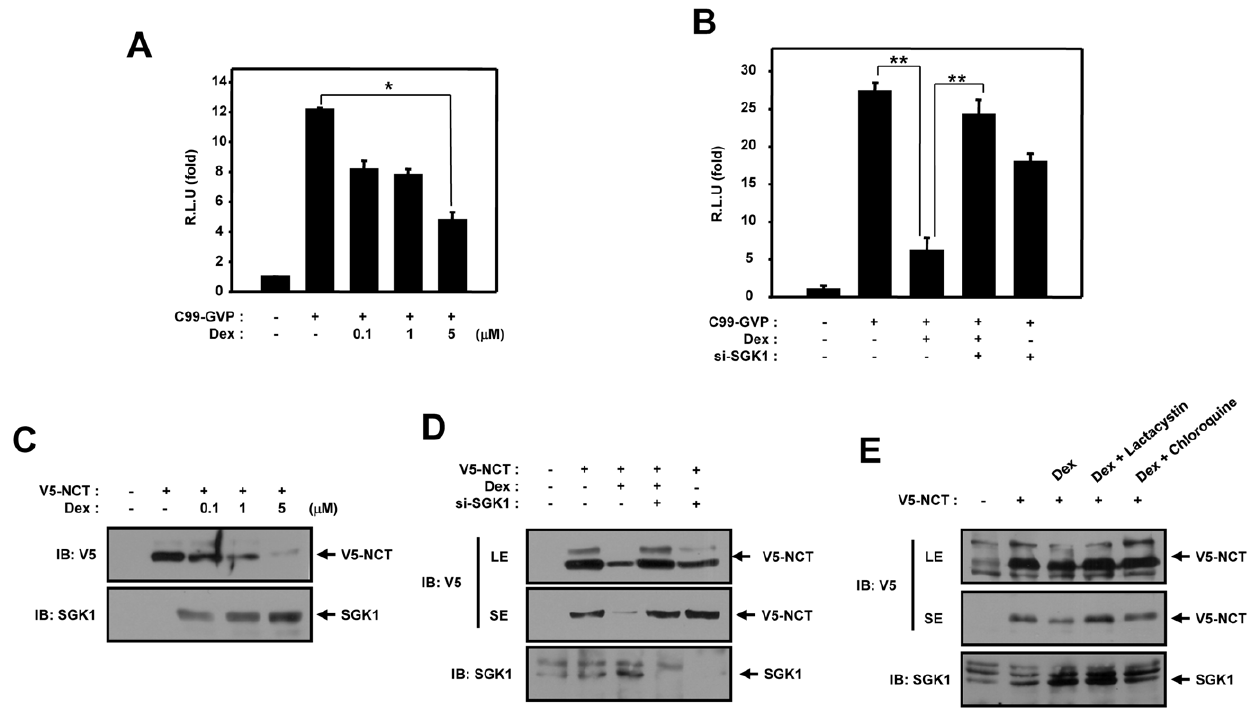
Figure 4. Induced SGK1 by dexamethasone downregulates the NCT protein levels. (A) HEK293 cells were transfected with expression vectors encoding for 200 ng of C99-Gal4/VP16, 100 ng of GAL4-Luc with 100 ng of beta-galactosidase and exposed to 0.1, 1, 5 m M dexamethasone for 24 hours. (B) HEK293 cells were transfected with expression vectors encoding for 200 ng of C99-Gal4/VP16, 100 ng of GAL4-Luc, 100 ng of beta- galactosidase with 400 ng of siSGK1 and exposed to 1 m M dexamethasone for 24 hours. After 48 hours of transfection, the cells were lysed and the luciferase activity was assayed. Data were normalized to beta-galactosidase activity. The results are expressed as the means 6 SEM from three independent experiments. RLU means relative luciferase units. The data were evaluated for significant difference using the Student’s t -test; ANOVA, * P , 0.05, ** P , 0.001. (C) HEK293 cells were transfected for 48 hours with expression vectors encoding for 1 m g of V5-NCT and exposed to 0.1, 1 and 5 m M dexamethasone for 24 hours. (D) HEK293 cells were transfected for 48 hours with expression vectors encoding for 1 m g of V5-NCT and 2 m g of si-SGK1and exposed to 5 m M dexamethasone for 24 hours. The cell lysates were immunoblotted with anti-V5 and anti-SGK1 antibodies. NCT blots are represented as short (SE) or long (LE) exposures. (E) HEK293 cells were transfected for 48 hours with expression vectors encoding for 1 m g of V5-NCT and pretreated with 1 m M dexamethasone for 24 hours. The cells were pretreated with Dexamethasone. After incubation with 10 m Mof Lactacystin or 200 m M of chloroquine for 6 hr, the cells were harvested and the cell lysates were immunoblotted with anti-V5 and anti-SGK1 antibodies. NCT blots are represented as short (SE) or long (LE) exposures. (C–E) These results represent one of three independent experiments. RLU means relative luciferase units. IB,